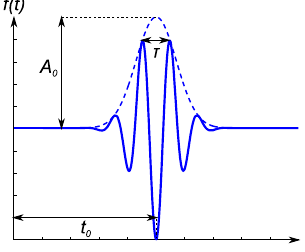
FIG. 1. Temporal signature of a single cycle pulse considered as the excitation in this